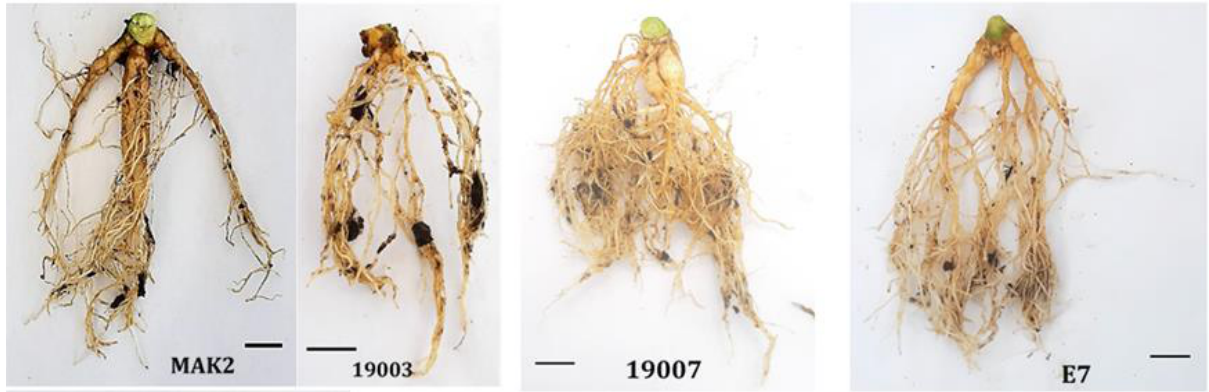
Figure 2. Morphological diversity of the root system of M. volkensii clones after two months of acclimatization under greenhouse conditions (scale bar = 1 cm).